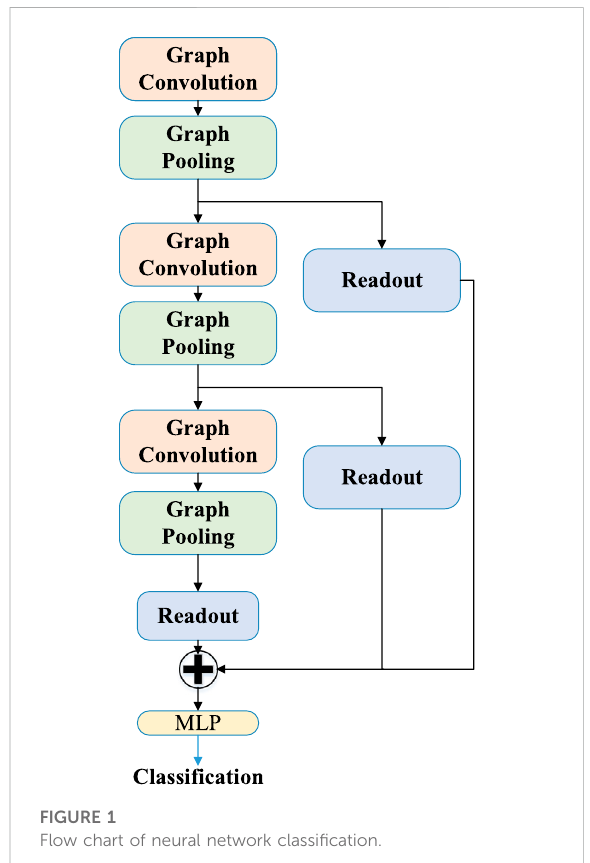
FIGURE 1 Flow chart of neural network classi fi